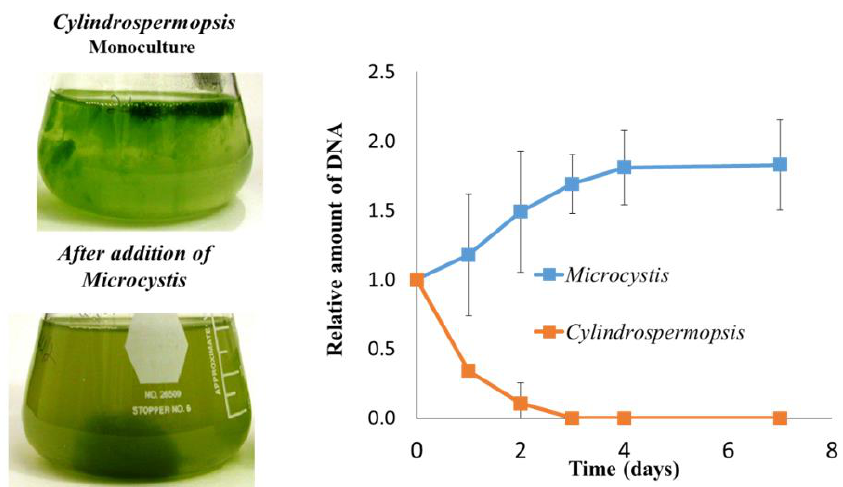
Figure 4. Microcystis – Cylindrospermopsis interaction. A monoculture of non-toxic Cylindrospermopsis raciborskii , mostly floating filaments (top Erlenmeyer flask), clustered together and sank to the bottom after the addition of M. aeruginosa sp. MGK cells (bottom Erlenmeyer flask). The right panel shows the changing level of specific DNA from each of the organism gauges via 16S rDNA analyses.